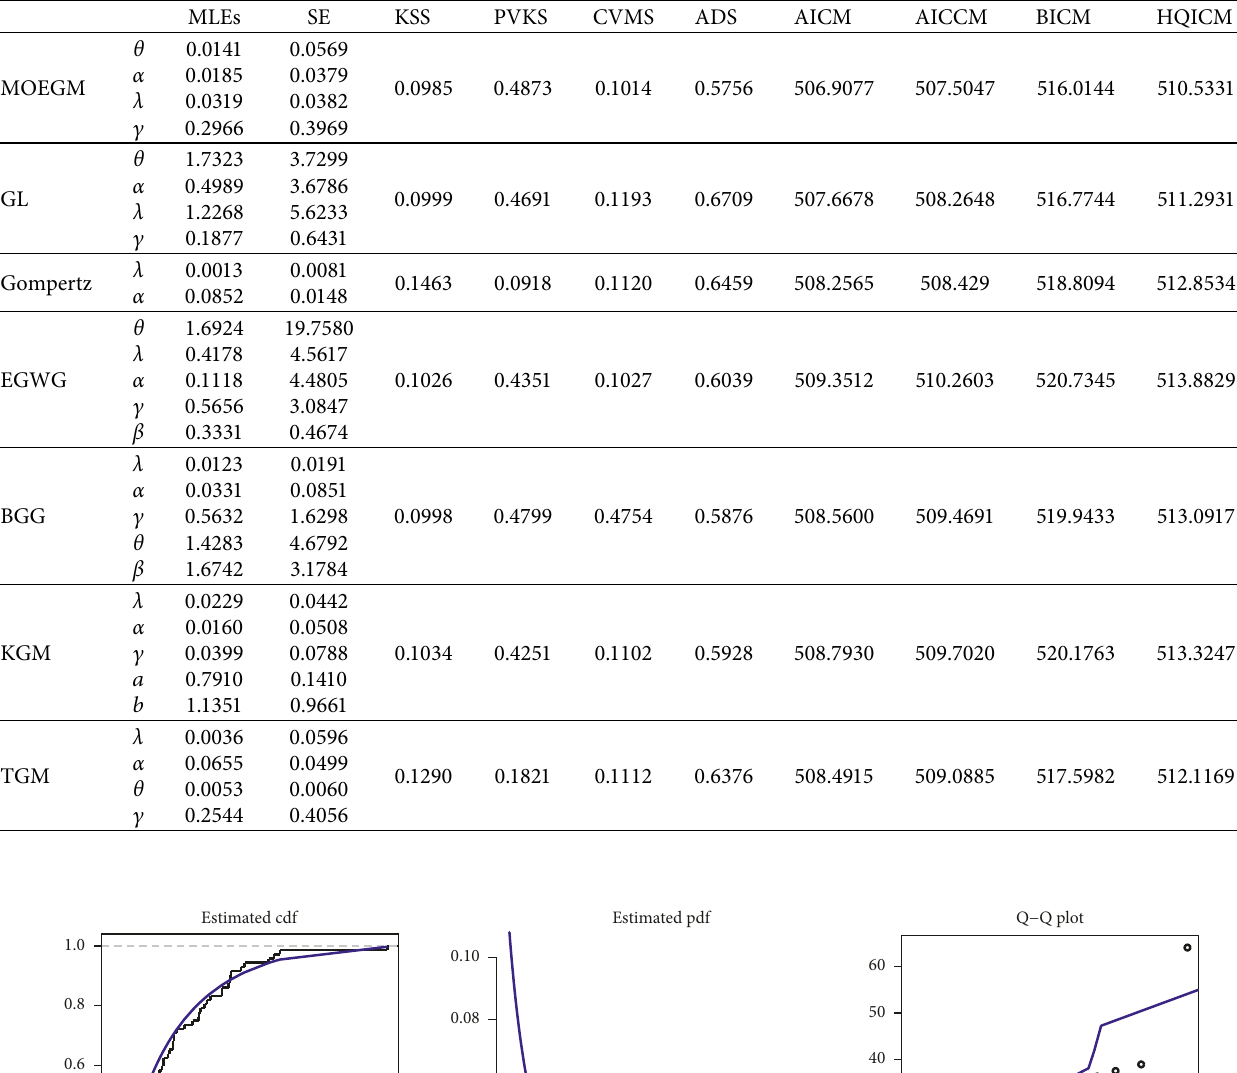
Table 4: MLEs of the models parameters with SE and different measures for fitting: flood peaks data.